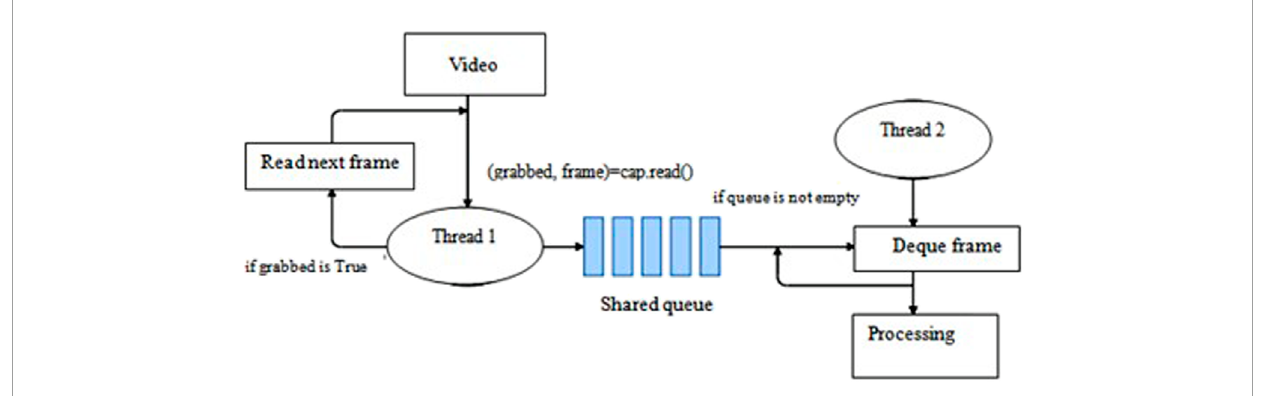
FIGURE 5 Using multithreading to reduce delay in reading frames.